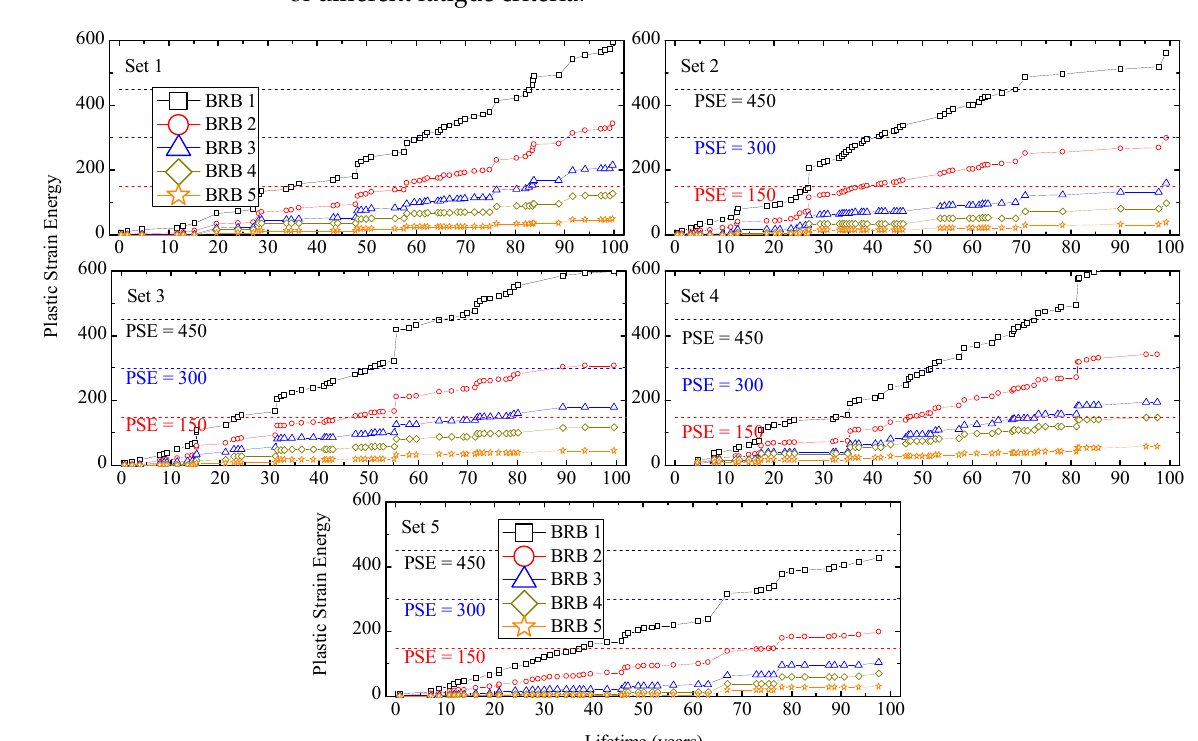
Figure 18. Plastic strain energy (PSE) of selected BRBs under multi-hazard scenarios.